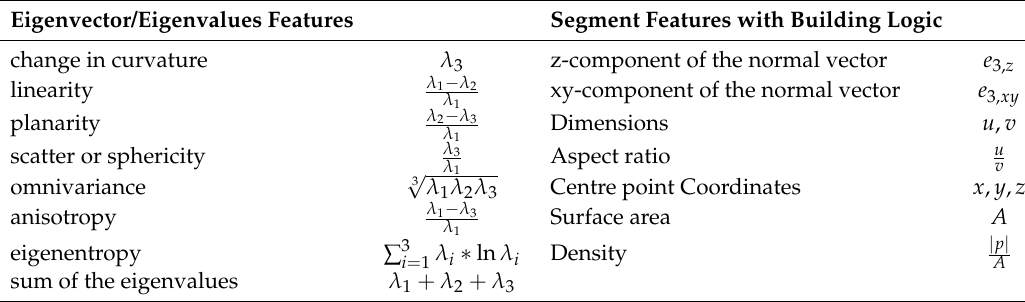
Table 1. List of common 3D geometric shape features used for building